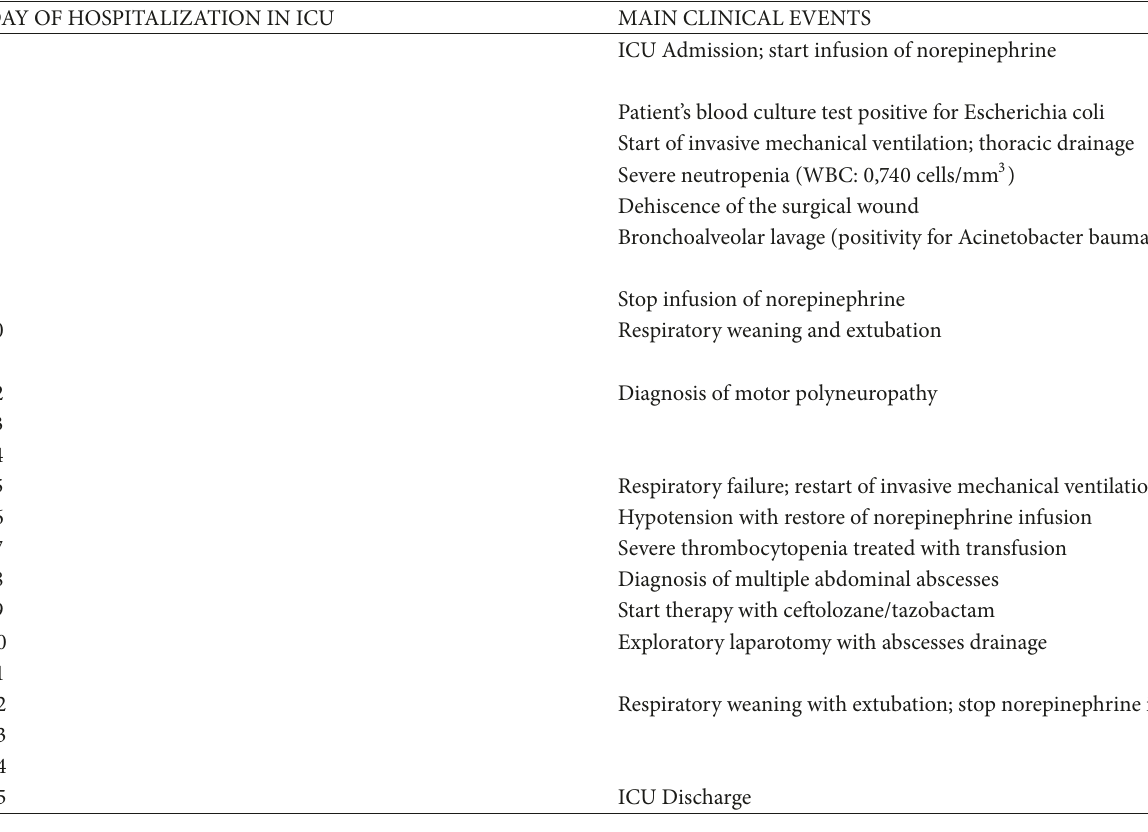
Table 1: Main clinical events during ICU hospitalization.